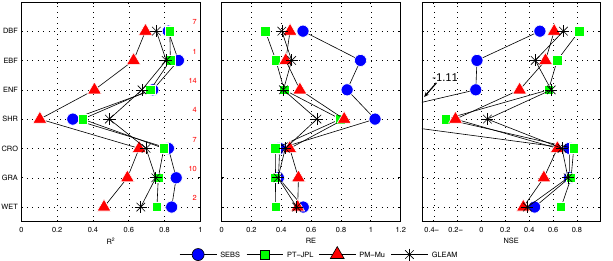
Figure 5. Coefficient of determination ( R 2 ), relative error (RE) and Nash–Sutcliffe efficiency (NSE) for models across different biome types. Each point represents the collection of all available 3-hourly records of towers located within the selected biome, with the num- ber of towers shown on the secondary y axis of the R 2 plot in red. NSE for the shrubland response of SEBS is printed.